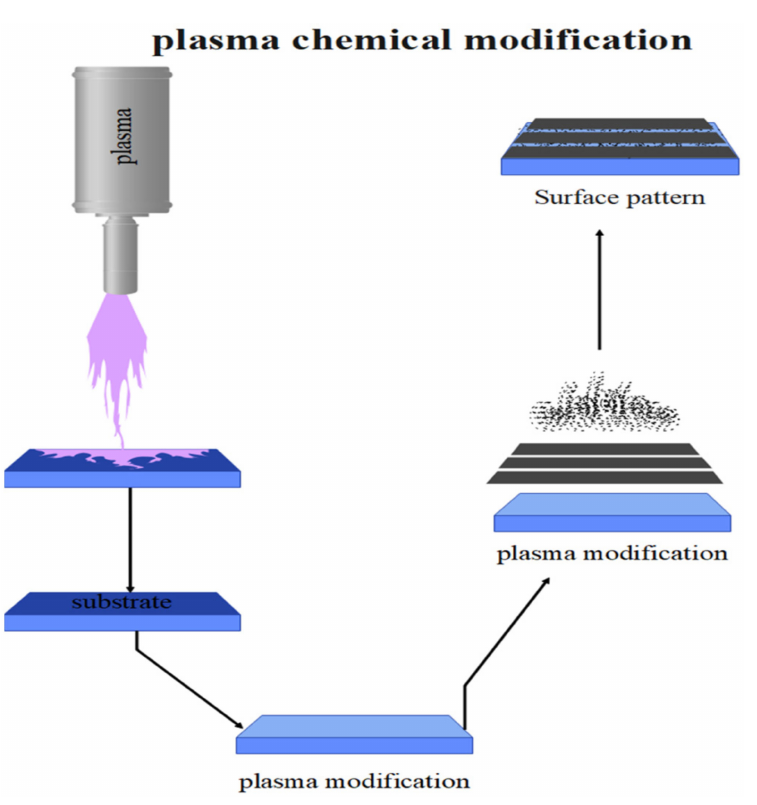
Figure 4. Plasma chemical